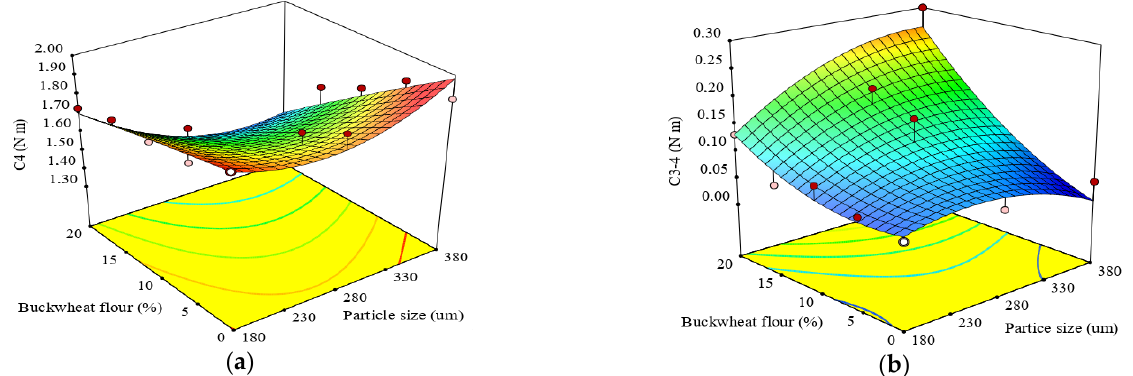
Figure 4. 3D response surface plots showing interaction between buckwheat flour particle size and addition level on ( a ) C4 torque (C4) and ( b ) difference between torques C3 and C4 (C3–4) during cooking stability.